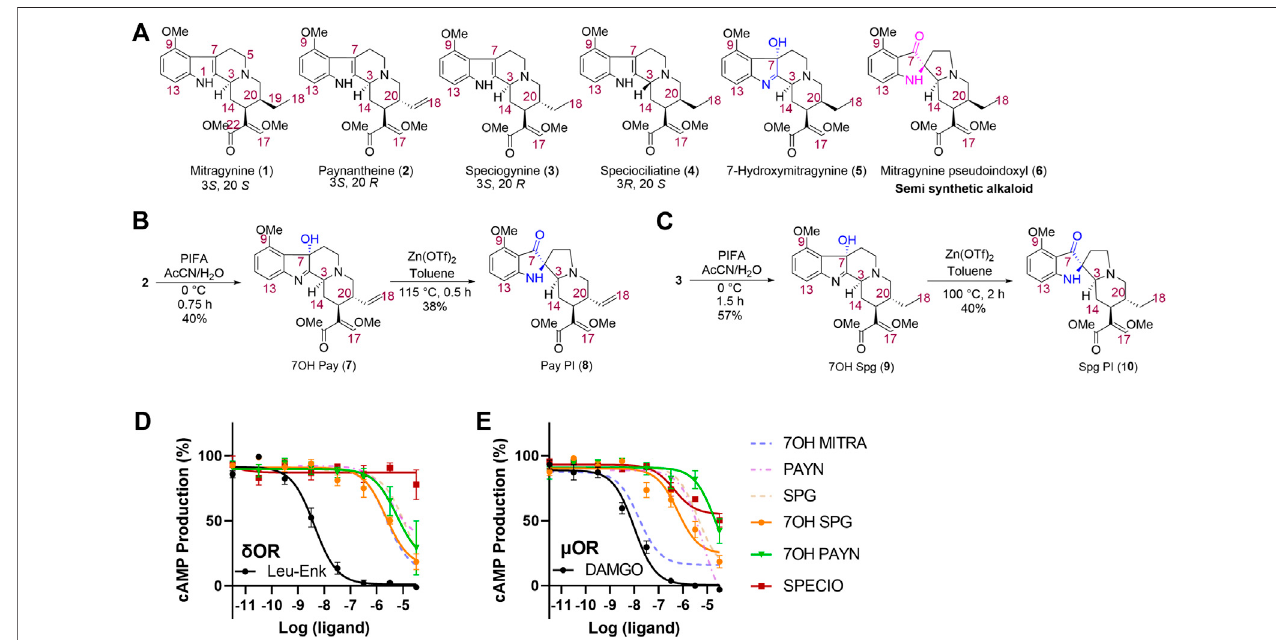
FIGURE 3 | Synthesis and characterization of kratom alkaloid analogs. Structures of naturally occurring kratom alkaloids paynantheine and speciogynine were used as scaffolds for analog synthesis. Analogs with pseudo-indoxyl (PI) rearrangements or hydroxyl group additions were made for both compounds, and a naturally occurring minor kratom alkaloid and speciogynine isomer, speciociliatine, was also synthesized for testing. (A) Chemical structures of selected indole-based kratom alkaloids; (B) synthesis of 7-hydroxypaynantheine (7) and paynantheine pseudoindoxyl (8); and (C) synthesis of 7-hydroxyspeciogynine (9) and speciogynine pseudoindoxyl (10). 7-hydroxyspeciogynine (7OH SPG, 9), 7-hydroxypaynantheine (7OH PAYN, 7), and speciociliatine (SPECIO, 4) are compared to kratom alkaloids (dashed lines; 7-hydroxymitragynine (7OH MITRA), paynantheine (PAYN), and speciogynine (SPG) for inhibition of forskolin-induced cAMP in a GloSensor assay in transfected HEK-293 cells at δ OR (D) and μ OR (E) . For additional in vitro characterization, see Supplemental Figure S4